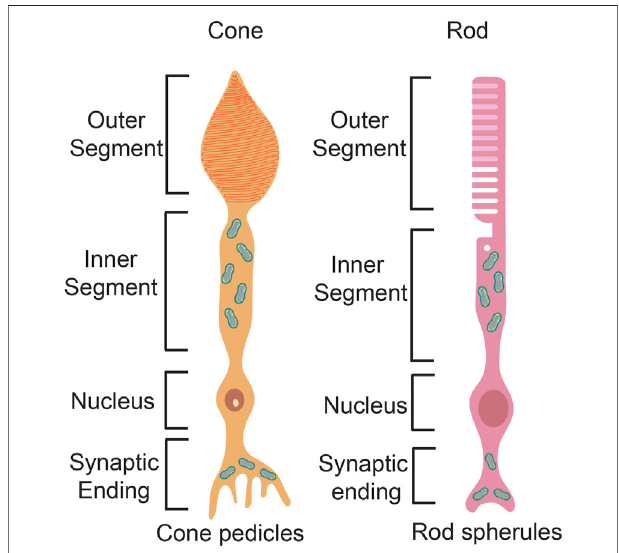
FIGURE 6 | Photoreceptor structure. Schematic representation of a rod photoreceptor and a cone photoreceptor, highlighting differences in the basal axon and the apical